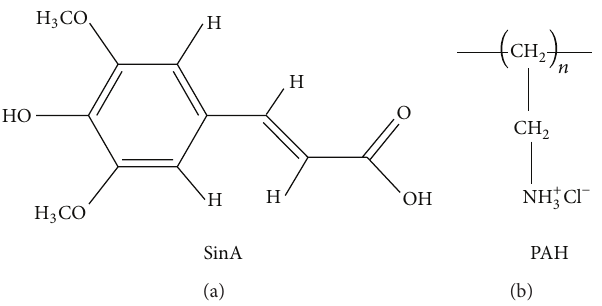
Figure 1: Chemical structures of sinapinic acid (SinA) and poly(allylamine hydrochloride) (PAH).